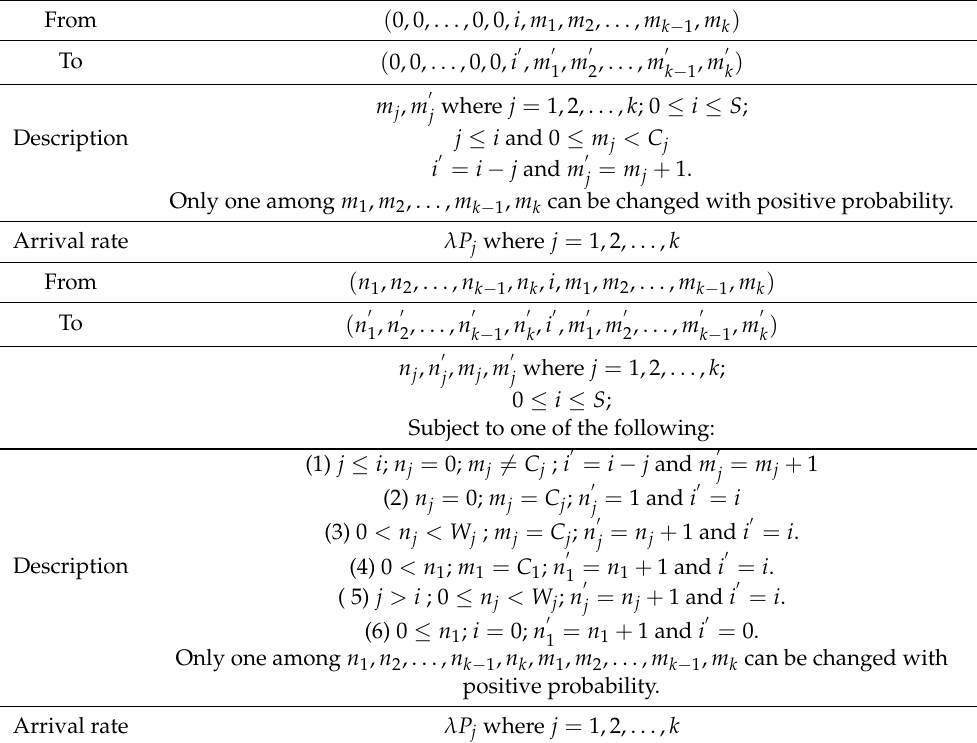
Table 1. Arrival